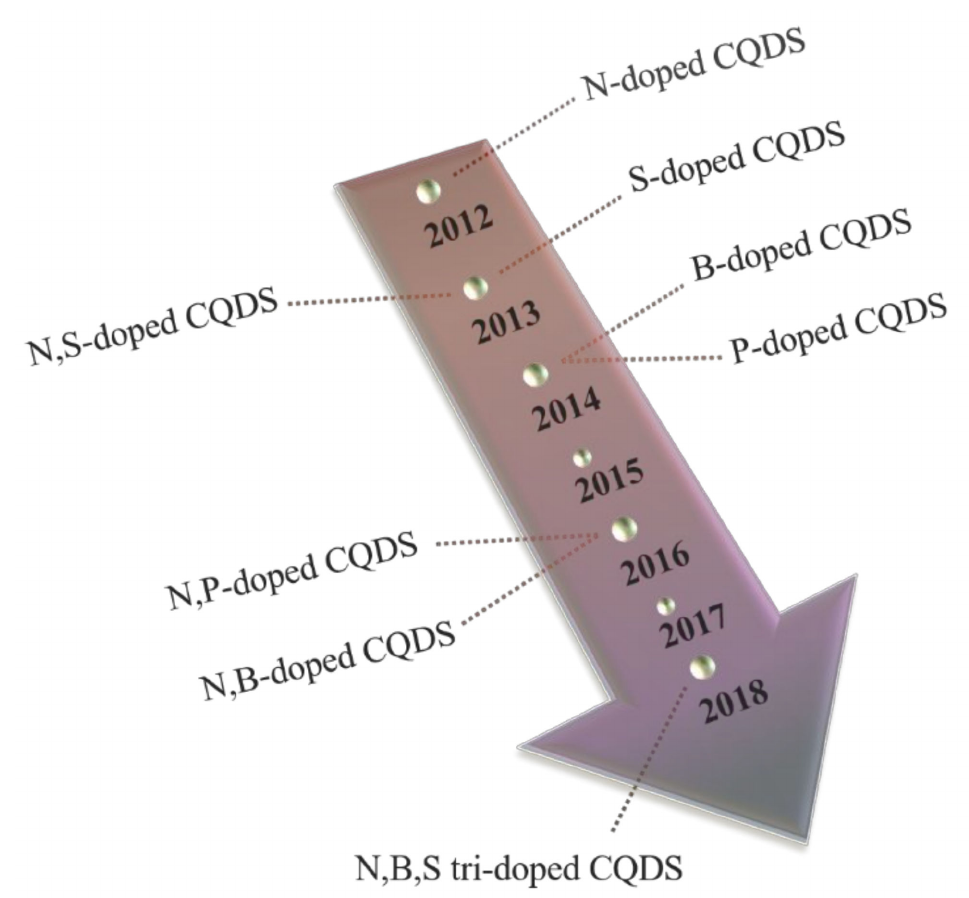
Figure 4. Heteroatom doping progress